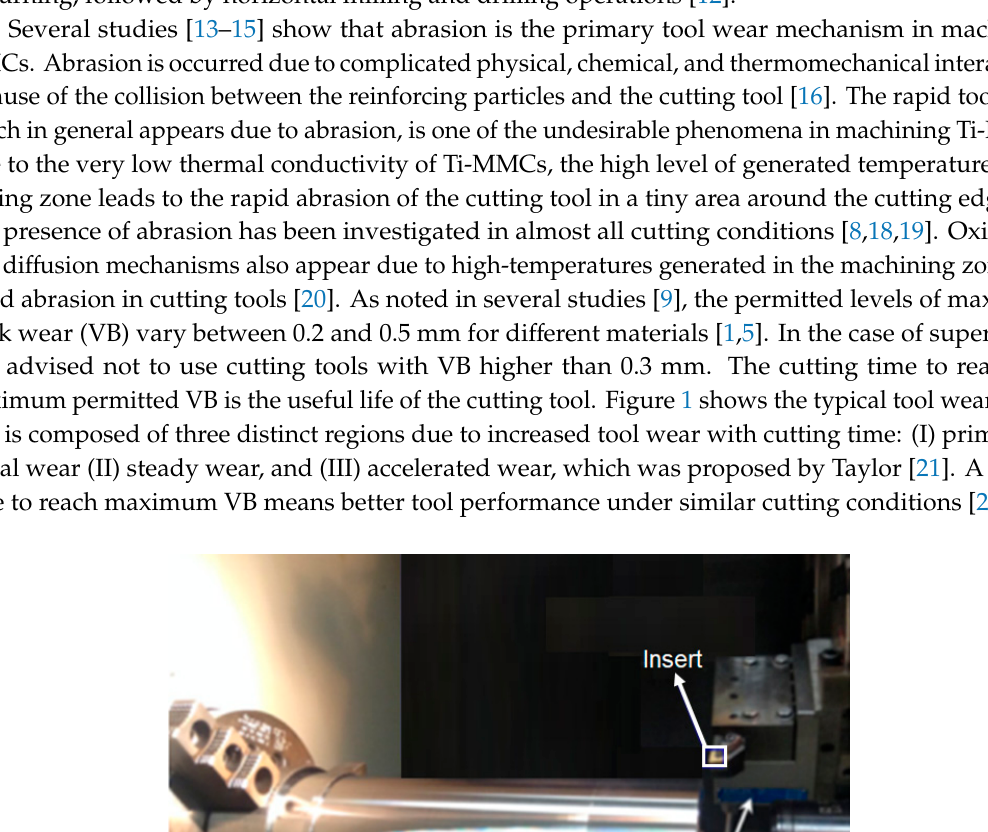
Table 1. The specifications of the inserts used.